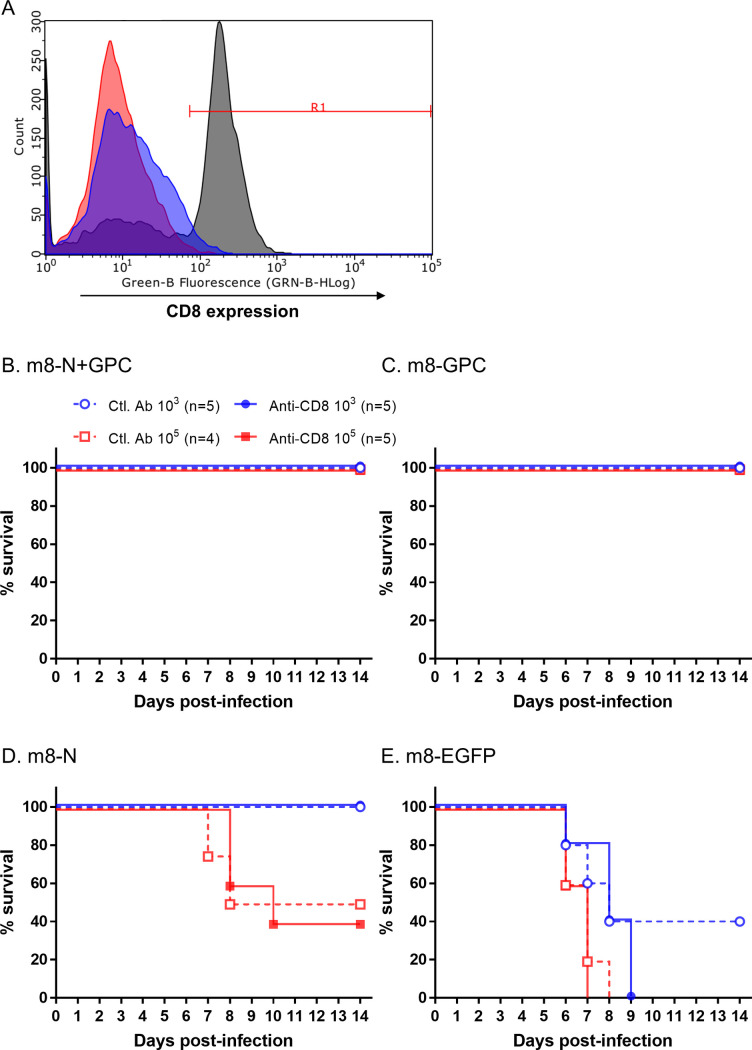
Survival in m8-SFTSV gene-inoculated mice with CD8-positive cell depletion following lethal SFTSV challenge.The efficacy of anti-CD8 mAb in depletion of CD8-positive cells in naïve IFNAR -/- mice were validated (A). A gate (R1), which separated a population of CD8 positive and negative cells, was adjusted using the histogram of splenocyte on 1 day after control mAb inoculation (Gray histogram), and the ratio of CD8 negative to positive cells was 36.1:63.9. Based on the gate, the ratio of CD8 negative:positive cells in splenocytes at 1 day (blue histogram) and 3 days (red histogram) after anti-CD8 mAb inoculation was 96.1:3.9 and 99.2:0.8, respectively. Next, IFNAR-/- mice were subcutaneously inoculated twice at a 2-week interval with a dose of 1 × 106 PFU of the m8-based SFTSV vaccines. Two weeks after the second inoculation of mice with m8-N+GPC (A), m8-GPC (B), m8-N (C) or m8-EGFP (D), the mice were challenged with 1 × 103 (blue circle) or 1 × 105 (red square) TCID50 of SFTSV YG-1 and were inoculated with anti-CD8 (strait line with filled symbol) mAb, to deplete the CD8-positive cells, or control (dotted line with open symbol) mAb on -1, 2, 5, and 8 DPI before and after SFTSV challenge. Survival was evaluated daily for 2 weeks. The number of mice in a group is shown as “n” in the legend.